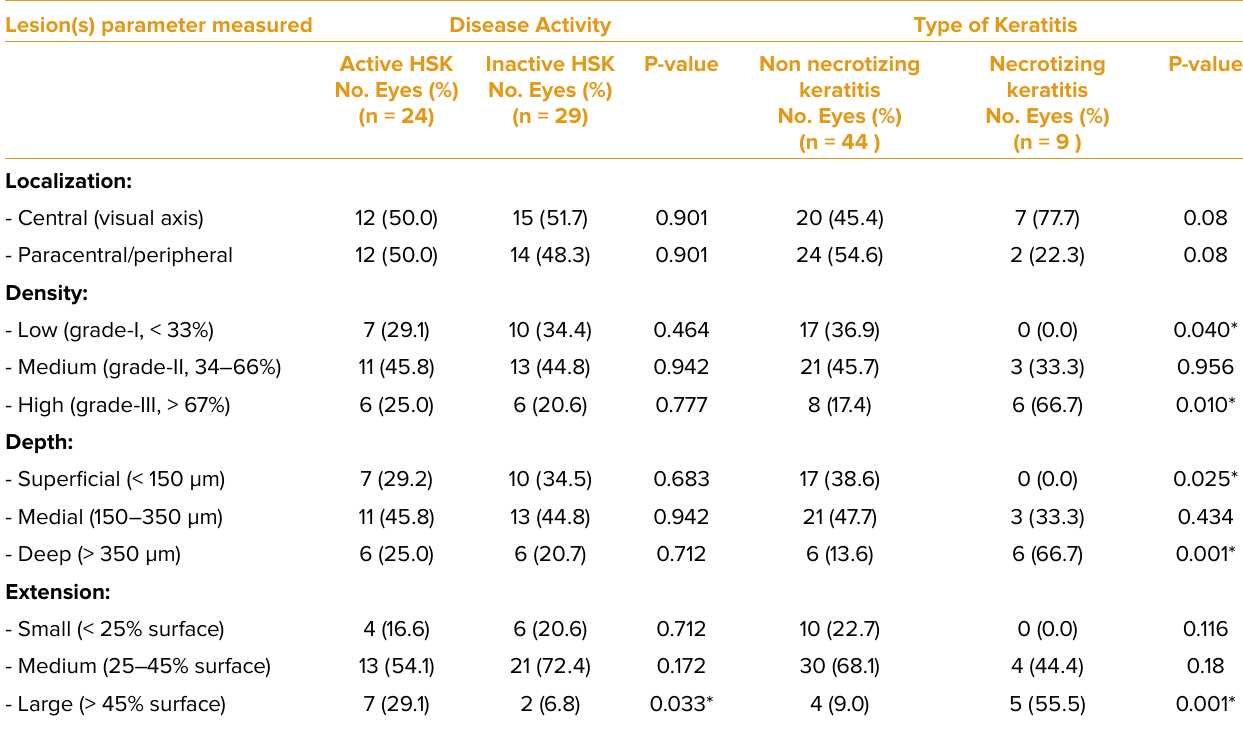
Table 2. SD-OCT cross-sectional analysis of most representative corneal lesions (scar, leukoma, or infiltrate) seen in eyes with herpetic stromal